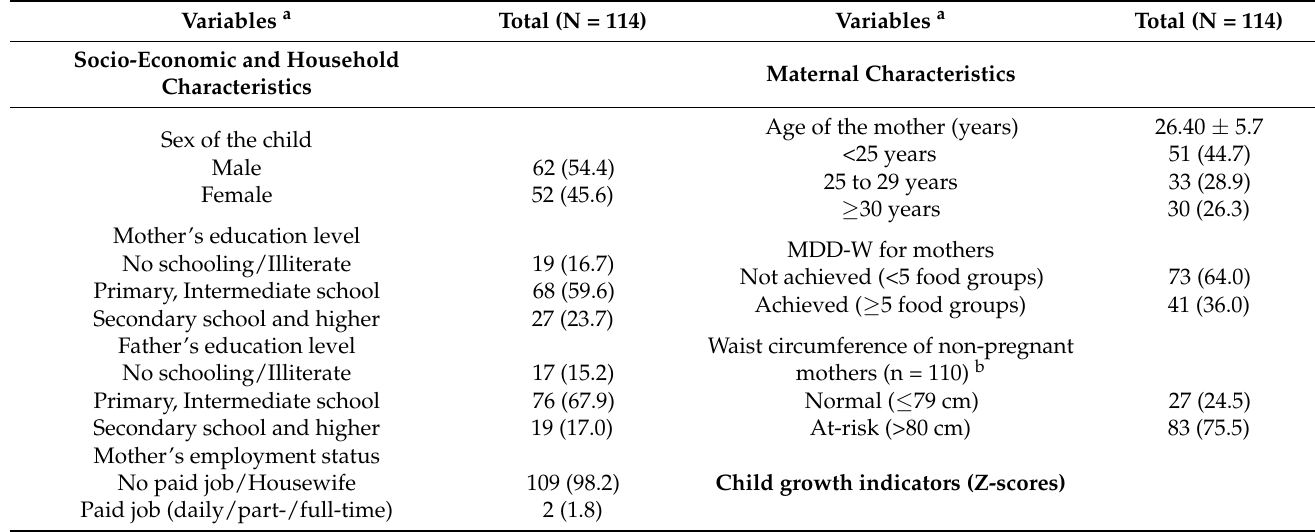
Table 1. Socio-economic, maternal characteristics, and child growth indicators of infants under six months among Syrian refugees in Greater Beirut,